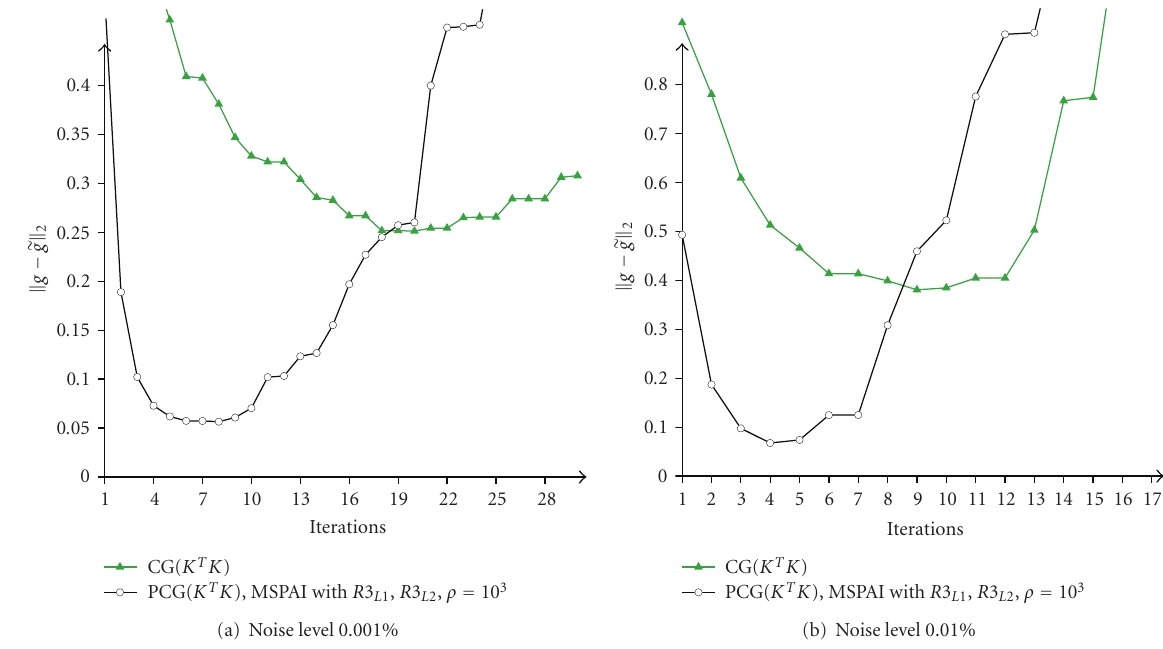
Figure 7: Reconstruction error against the iteration for the noise of order 0.001% (a) and 0.01% (b), respectively. CG is compared to PCG using MSPAI with R 3 L 1 , R 3 L 2 , and ρ = 10 3 for the normal equations. MSPAI is symmetrized via M + M T